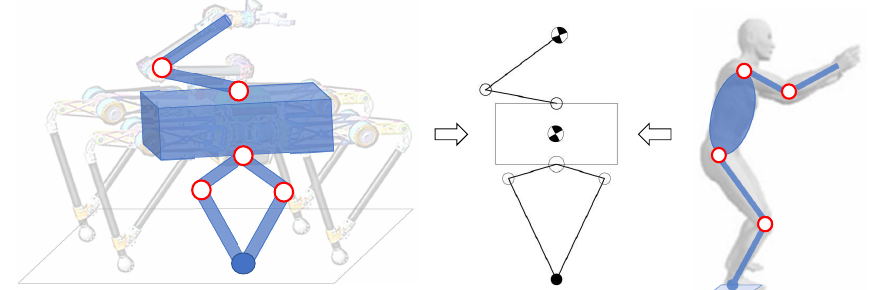
Figure 4. The simplified model of quadruped robot inspired by human